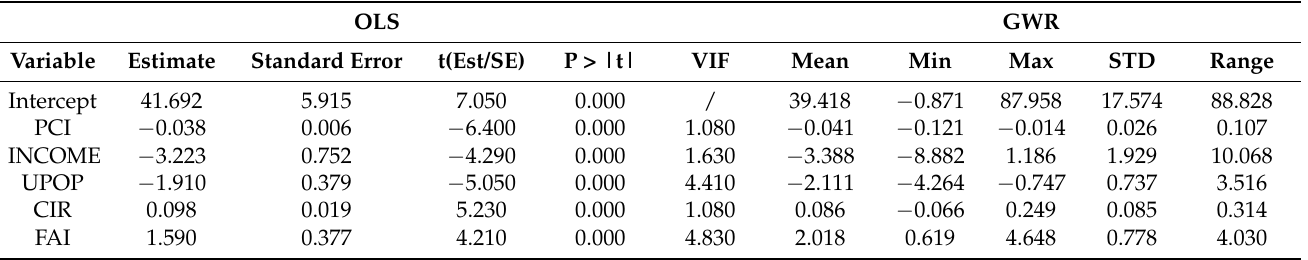
Table 6. Parameters of OLS model and the summary statistics for varying (local) coefficients of variables in GWR